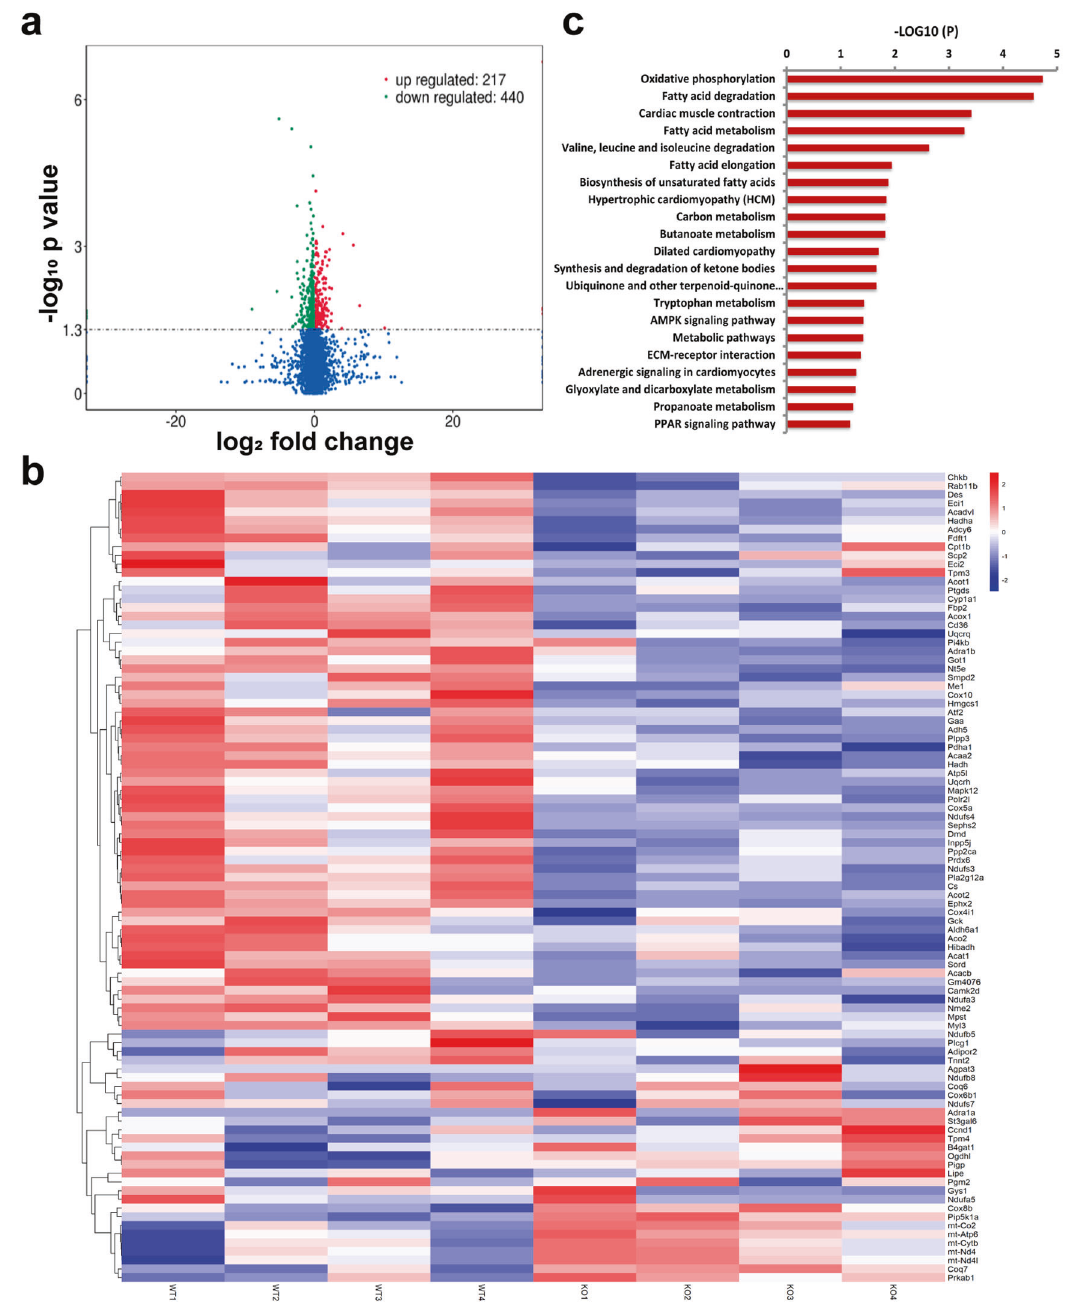
Fig. 5 RNA-sequencing analysis of myocardial tissues in mice. a Volcano plot showing the transcript expression pro fi les in the hearts of A17 α - MHCKO and ADAM17 fl / fl diabetic mice, respectively. The horizontal line marked the threshold ( P < 0.05) for de fi ning upregulated (red dot) or downregulated (blue dot) genes in the myocardium of A17 α -MHCKO diabetic mice. The x -axis indicated log 2 fold change and the y -axis indicated − log 10 P -values. b Hierarchical clustering of the top 50 (ranked by P -values) genes differentially expressed in hearts from the A17 α - MHCKO and ADAM17 fl / fl diabetic mice. c KEGG pathway enrichment analysis of differential expression (DE) transcripts in the heart. The DE transcripts falling into the top pathways were summarized. The x -axis indicated – log10 ( P -values) of the pathway and the y -axis displayed functional pathways